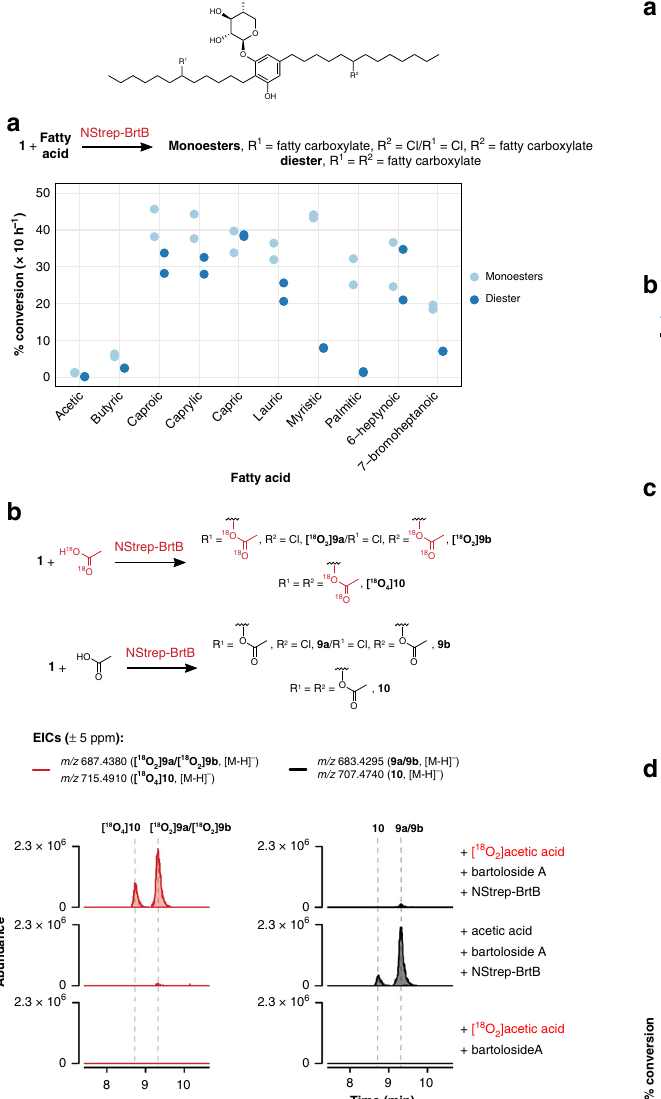
Fig. 3 Substrate scope of BrtB and nature of the nucleophile. a Mono- and diesters are formed upon incubation of BrtB and 1 with different fatty acid substrates for 10 h. Conversion values were obtained from areas of reaction product EIC peaks obtained using LC-HRESIMS analysis and assuming similar ionization behavior. Full reactions were carried out in duplicate and contained 0.8 μ M recombinant NStrep-BrtB, 100 μ M of 1 and 200 μ M of fatty acid in reaction buffer. b LC-HRESIMS analysis of BrtB esteri fi cation reactions between 1 and [ 18 O 2 ]acetic acid or non-labeled acetic acid indicate that two 18 O atoms are incorporated into the product per ester moiety. error, n = 3) and 0.13 ± 0.01 μ M min − 1 (standard error, n = 3)